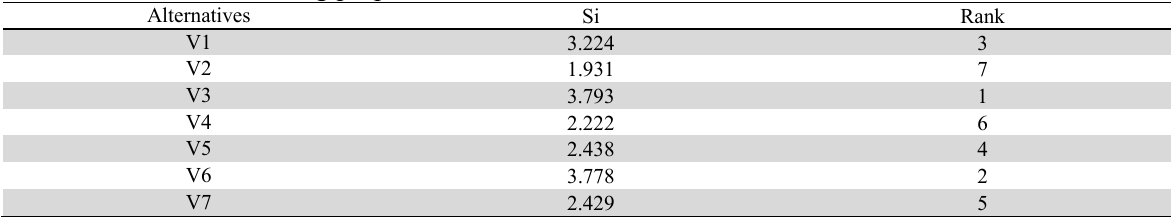
Rank of the alternative using proposed